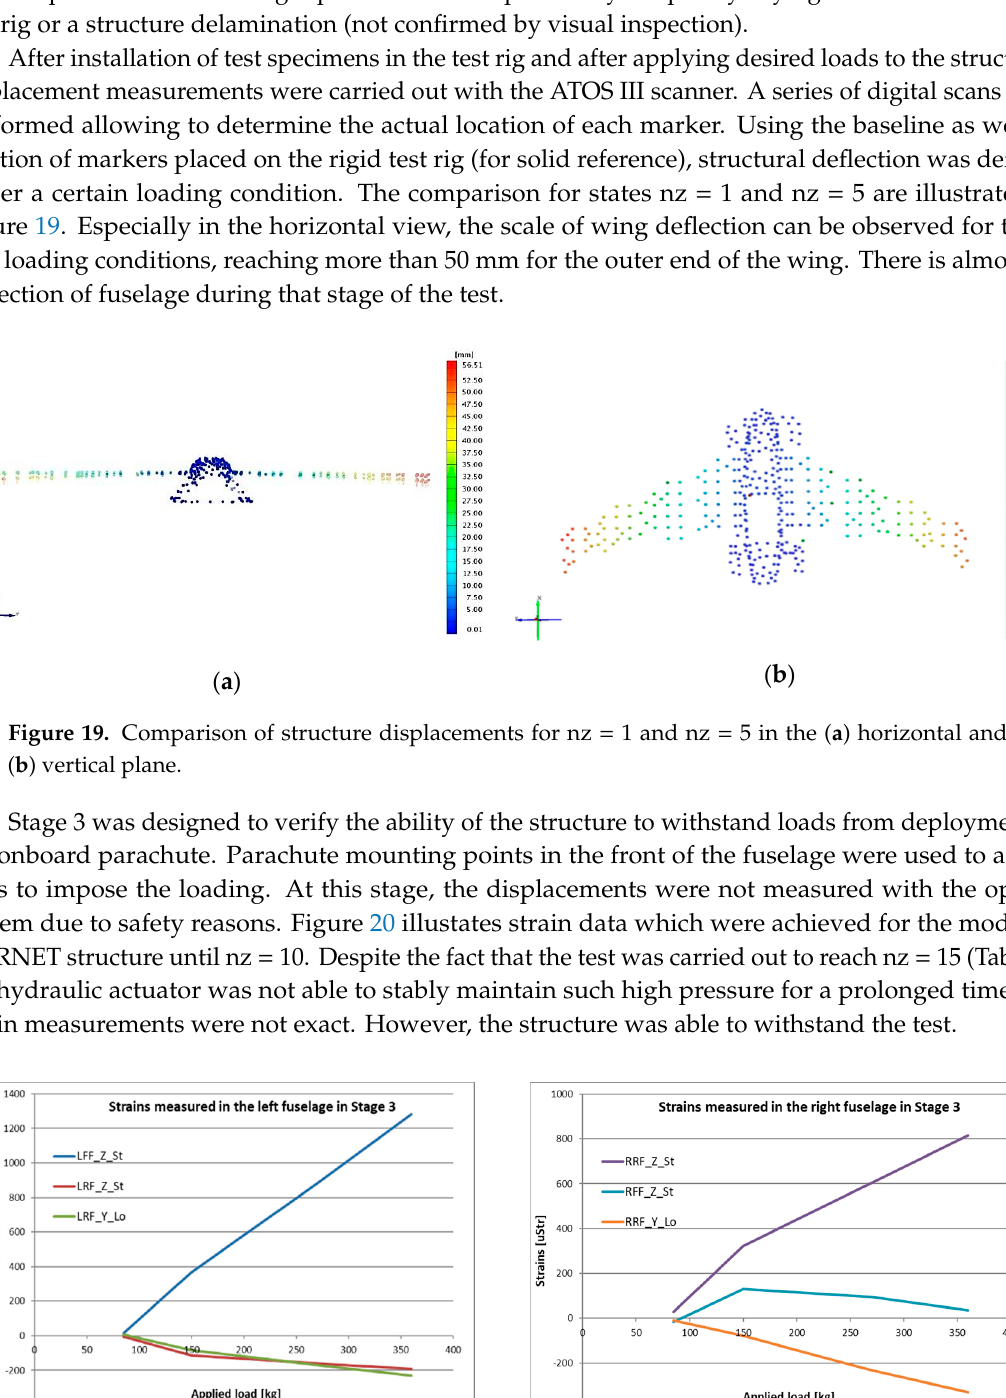
Table 3. Load conditions used in Stage 3—parachute